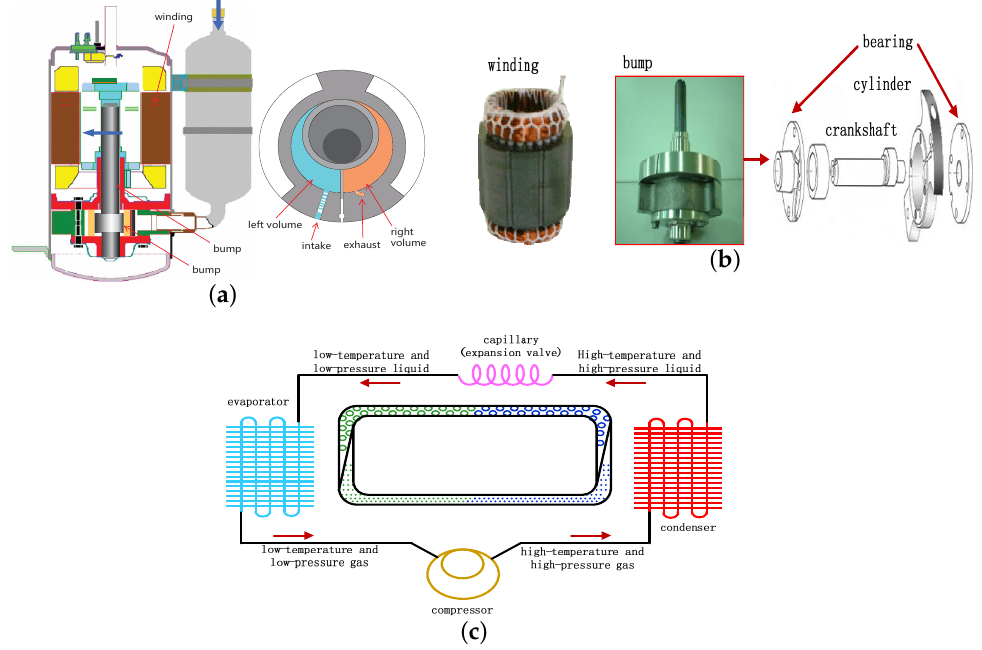
Figure 1. Structural diagram of inverter compressor and operation cycle: ( a ) inverter compressor structure; ( b ) stator winding and bump; ( c ) refrigeration loop of air-conditioner.